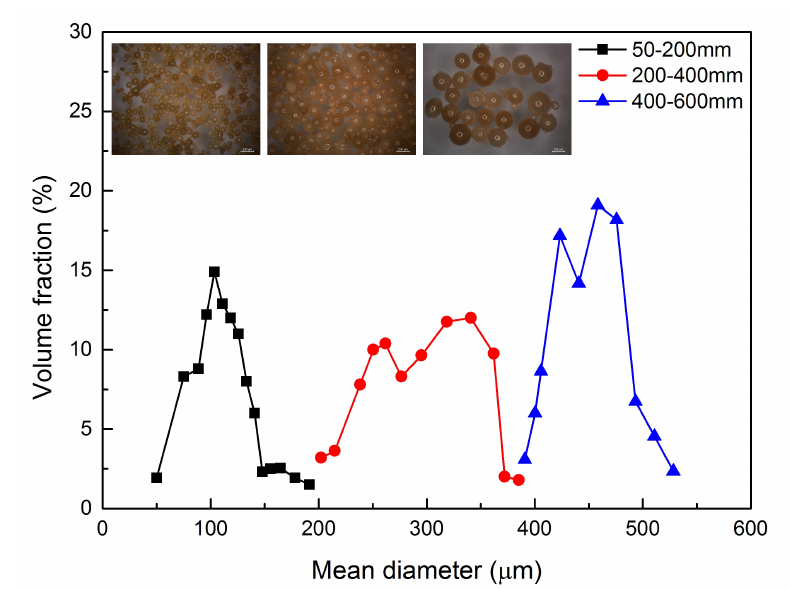
Figure 10. Size distribution of the PF microcapsules screened by sieves with various mesh sizes (30, 40,